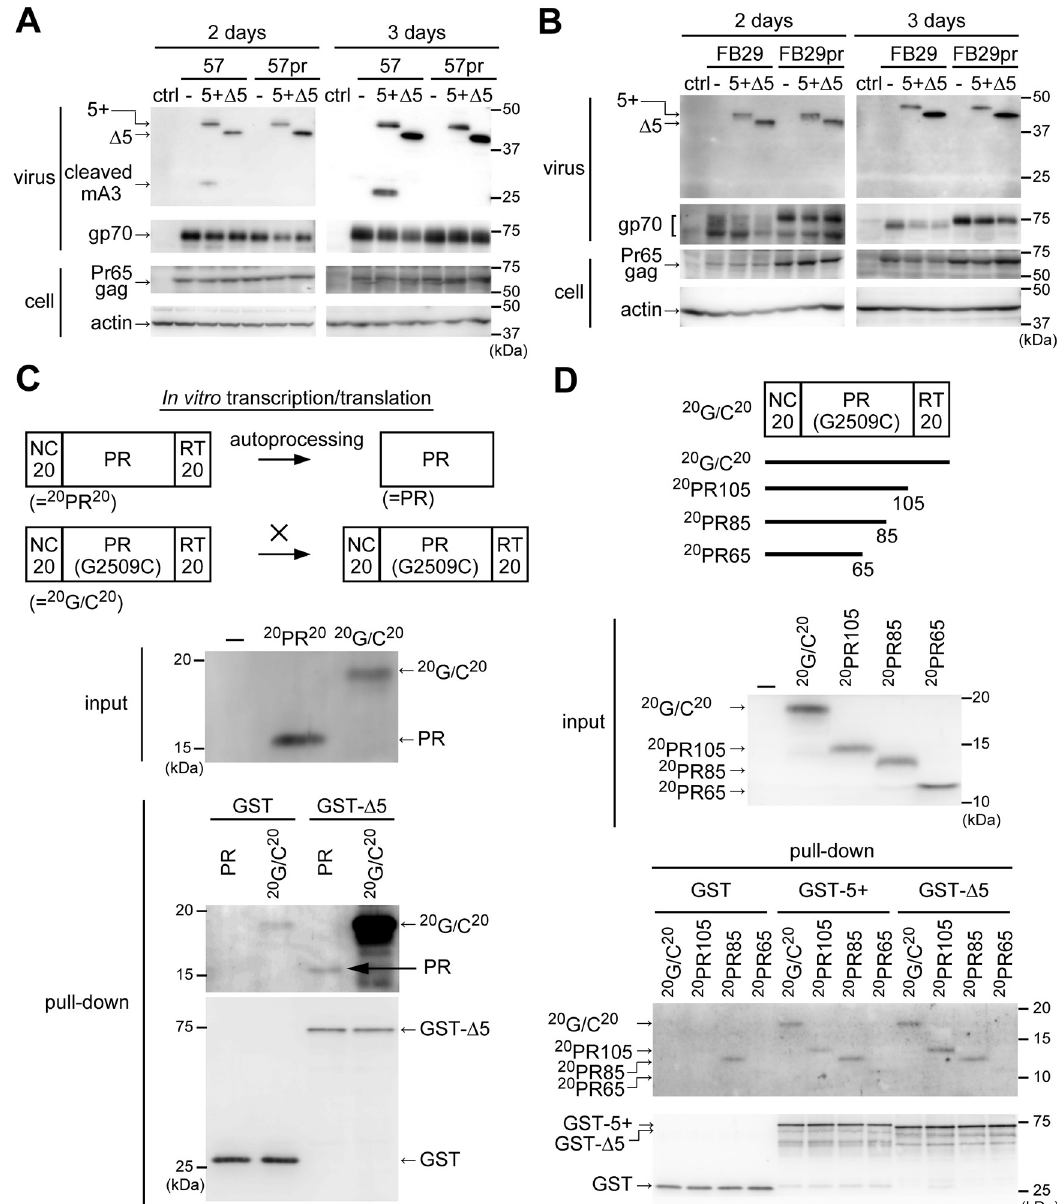
Fig 2. mA3 interacts with F-MuLV protease. (A) 293T cells were transfected with 6 μ g of F-MuLV 57- or 57pr-encoding plasmid along with 1.5 μ g of the FLAG-tagged mA3 (5+ or Δ 5) expression one or the control ( − ) parental pCMV2-FLAG plasmid. Viruses and the cells were collected at the indicated time-points after transfection, and analyzed by immunoblotting. Anti-p15 (MA) mAb clone 690, anti-F-MuLV gp70 (SU) mAb clone 720, and anti-actin Ab C-11 were used to detect Pr65gag, gp70, and cellular actin, respectively. To detect mA3, the anti-FLAG mAb M2 was used. (B) The same experiments were performed as described for panel A except that FB29 and FB29pr were used. (C) The enzymatically active WT viral protease (PR) or the inactive G2509C mutant protein (PR (G2509C)) from strain 57 were prepared by using the in vitro transcription/translation system (input). Both proteins were initially expressed with twenty amino acid residues flanking each end of the protease. Since the flanking peptides of 20 PR 20 were autocatalytically cleaved by active PR, the processed mature viral protease migrated to produce a signal at around 15kDa. On the other hand, the mutant 20 G/C 20 is unable to cut the flanking peptides, resulting in the band with a molecular mass higher than that of mature viral protease. For the control ( − ), no DNA was added in the reaction. For the pull-down assays, GST or GST-conjugated Δ 5 mA3 bound on Glutathione Sepharose 4B was mixed with the above expressed PR or 20 G/C 20 . The associated protease in the pulled- down fraction was detected by immunoblotting using the rabbit anti-MuLV protease Ab we prepared. For the detection of GST- conjugated proteins, the anti-GST Ab was used. (D) Deletion mutants of strain 57 protease were synthesized by the in vitro transcription/translation system. These were mixed with GST, GST-conjugated Δ 5, or GST-conjugated 5+ mA3 bound on Glutathione Sepharose 4B. The associated protease or its fragments were detected by immunoblotting as described for panel C.